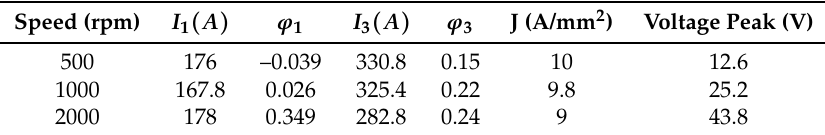
Table 3. Optimal resolution of MTPL(I) strategy at low